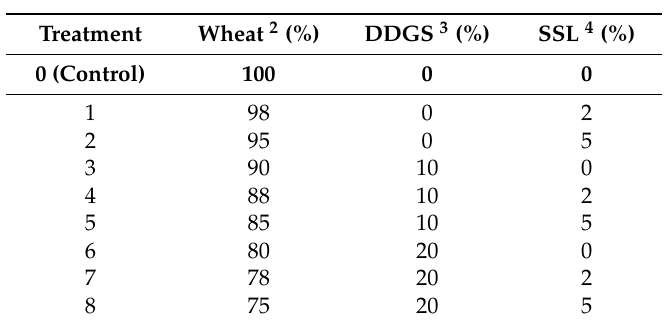
Table 1. Experimental design 1